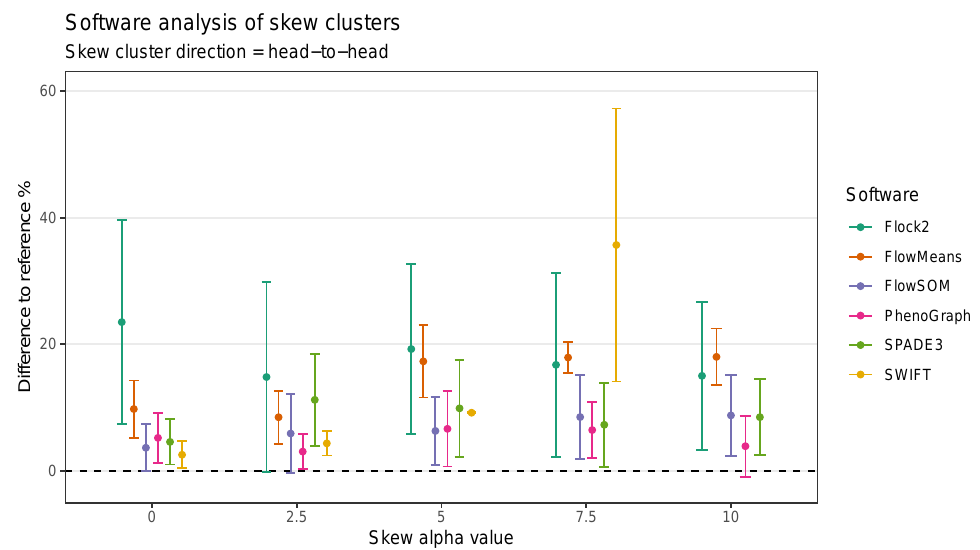
Figure 9. Performance of different software on a dataset with skew cluster orientations facing head to head.